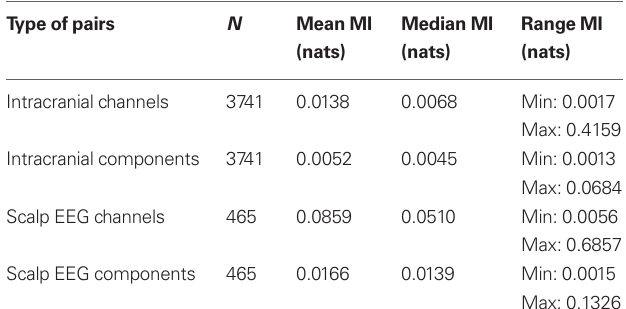
Table 2 | Statistics on histogram of the pair-wise mutual information for Patient